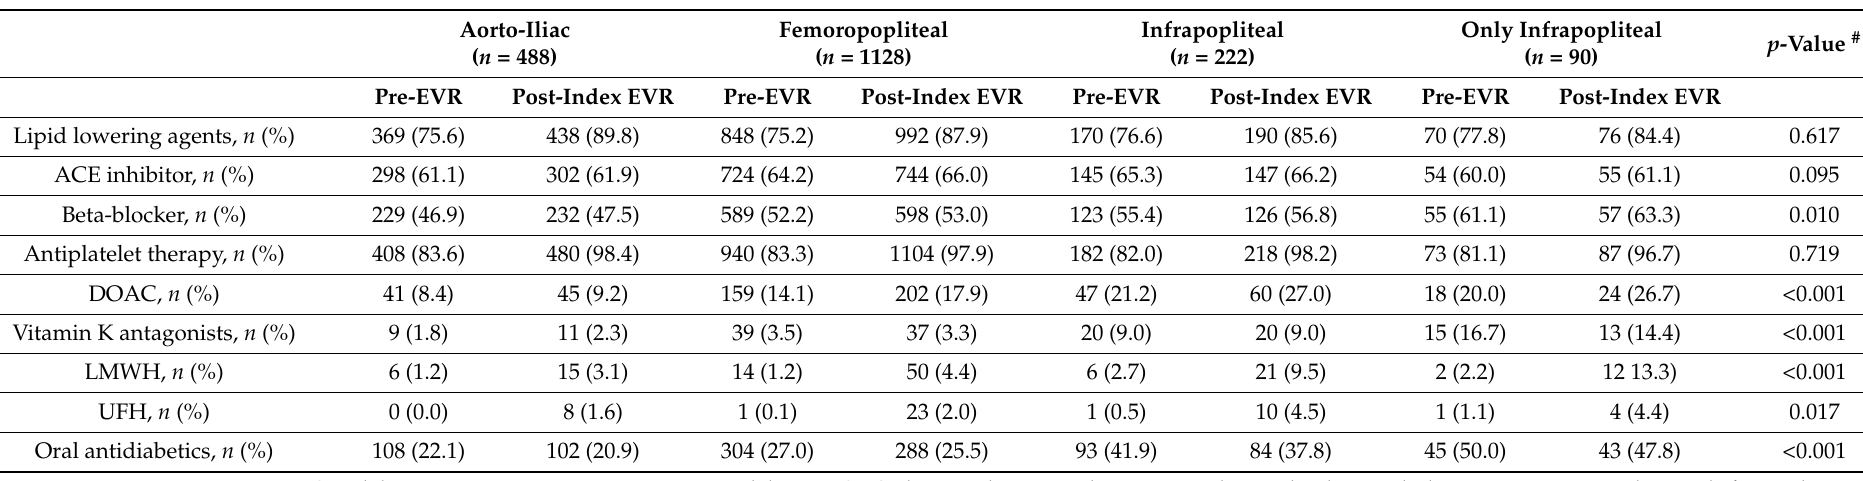
Table 4. Medication at baseline at the time point of inclusion in the RECCORD registry (pre-EVR) and after the index endovascular revascularization (EVR). Aorto-Iliac ( n = 488)